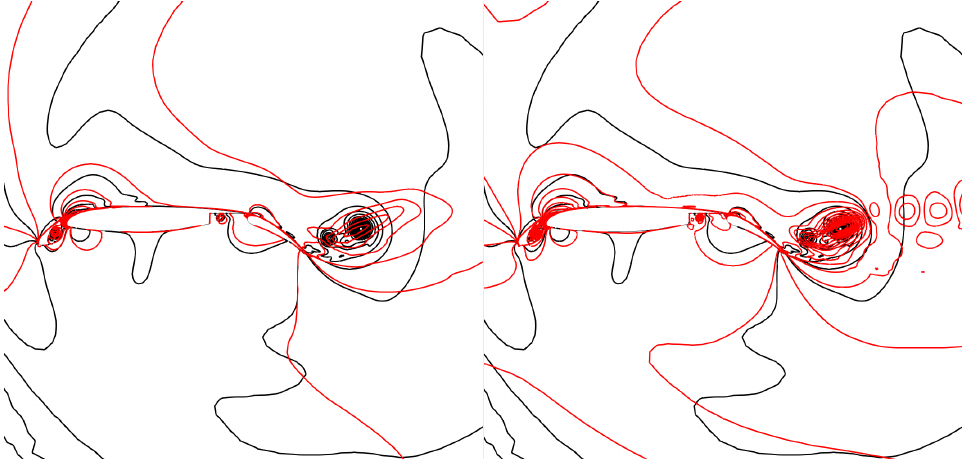
Figure 8. Volume reconstruction of density at time t = 0.0054 s for 6 modes ( left ) and 17 modes ( right ), 30P30N test case. Black contours represent the CFD reference solution; red contours represent the ROM reconstructed